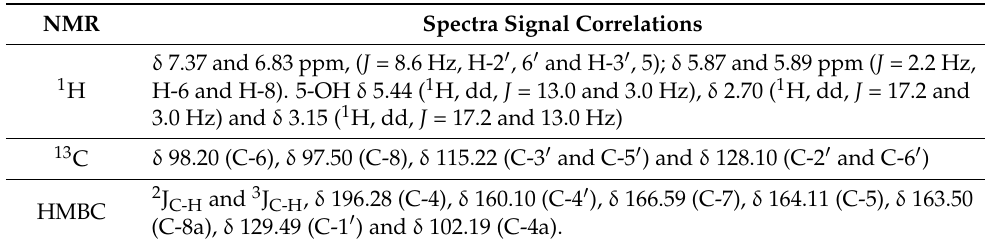
Table 3. NMR spectroscopy data for naringenin isolated from E. magalismontanum